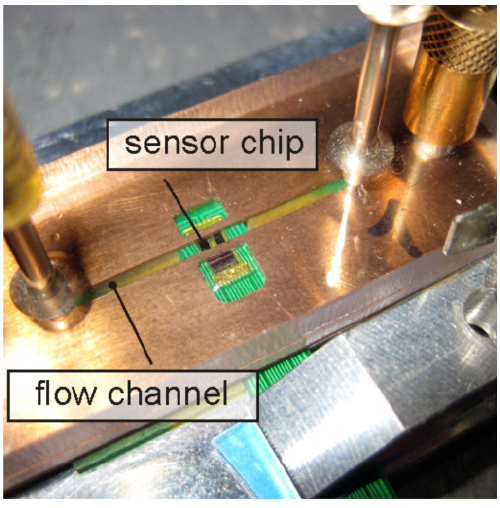
Figure 7. Sensor chip incorporated in a printed circuit board (PCB) and then flush mounted into the wall of miniaturized flow channel with cross-sectional dimensions 1.2 × 0.5 mm 2